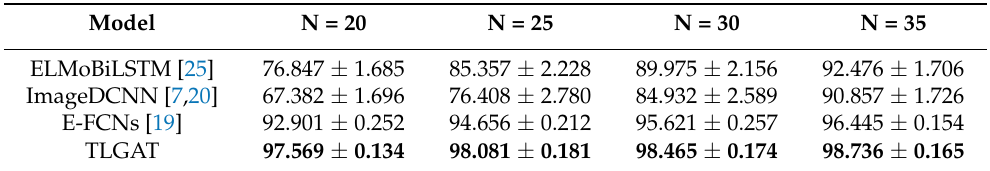
Table 4. The overall F 1 - score ( % ) (mean ± 3 σ ) of ELMoBiLSTM, ImageDCNN, E-FCNs, and TLGAT in the MILAN dataset.